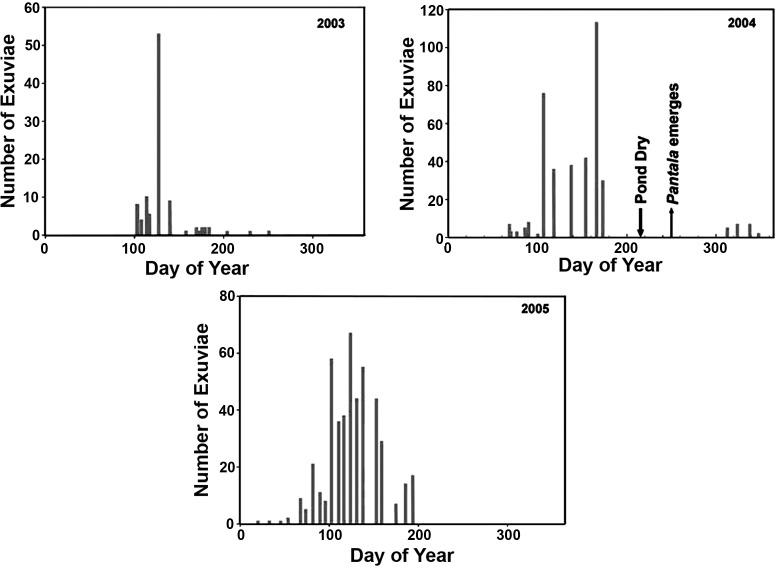
Numbers of Anax junius exuviae collected throughout the varying portions of the emergence periods in 2003–2005 at a single pond in Austin, TX; each vertical line indicates one day’s collection.Note that the scale of the y-axis varies among plots. During 2003 and 2005, collections were ended at about day 200 and day 250, respectively. Downward pointing arrow indicates the date on which the pond became almost completely dry and anoxic in 2004; upward pointing arrow indicates emergence, after partial refilling, of Pantala flavescens. Underlying data in S8 Table.